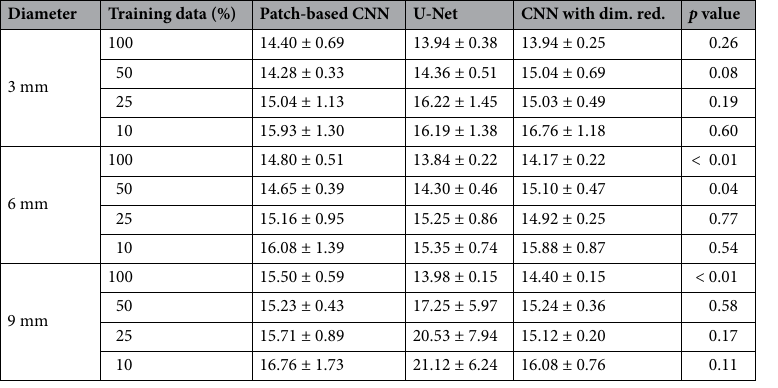
Table 2. Mean absolute error in μm of corneal thickness predictions on test set for varying partitions of the training set. Mean ± standard deviation of 5 training repetitions. p values were calculated by one-way ANOVA and represent the chance that model performances are similar.